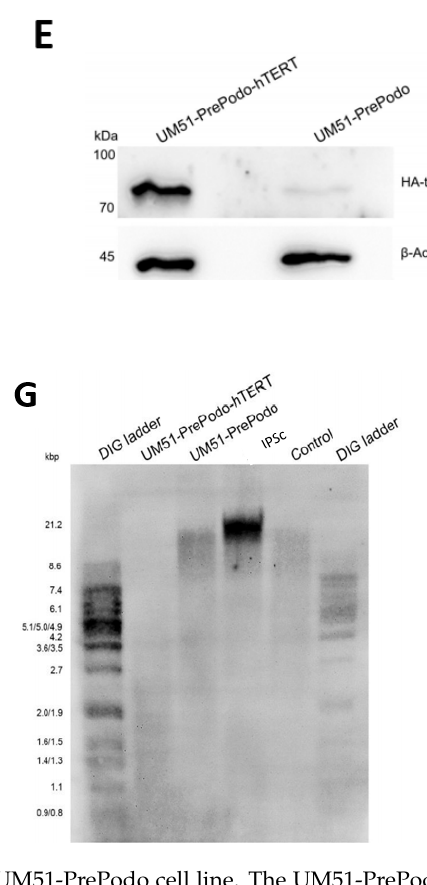
Figure 1. Successful immortalization of the UM51-PrePodo cell line. The UM51-PrePodo cell line was successfully immortalized by transfection with the pCDNA-3xHA-hTERT plasmid. Morphology after transfection as observed by light microscopy ( A ). P53 and phosphorylated P53 expression in the immortalized cells were monitored by immunofluorescent-based detection ( B ) (scale bars: 100 µ m). Integration of the plasmid was visualized by immunofluorescence-based and Western blot detection of the HA-tag ( C , E ). Karyotyping of UM51-PrePodo-hTERT revealed a hypertriploid karyotype with several alterations ( D ). Expression of the hTERT gene was determined by quantitative real-time PCR ( F ). Telomere length was measured by Southern blotting ( G